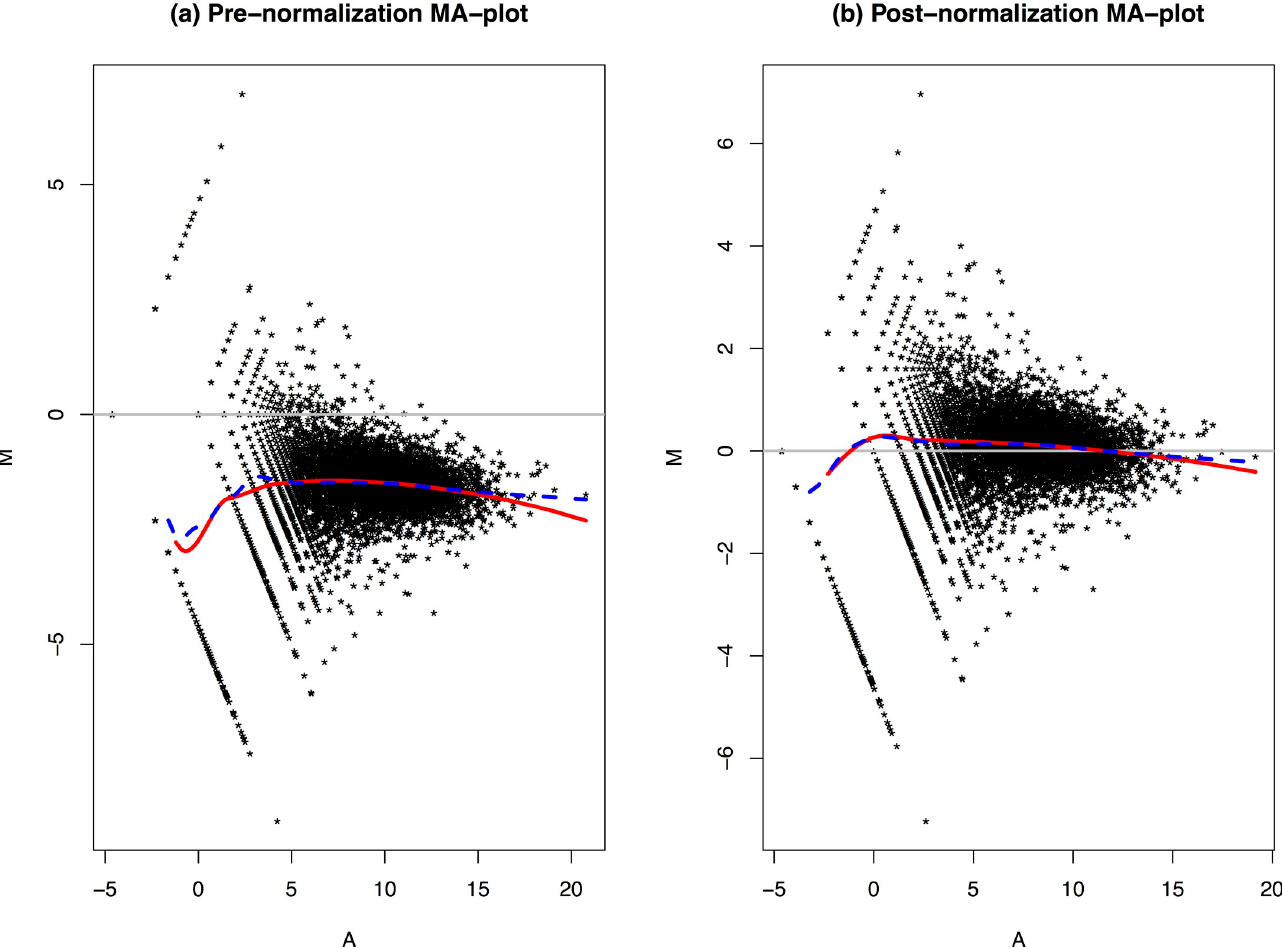
Fig 3. Comparisons of normalization results for profiles 47 and